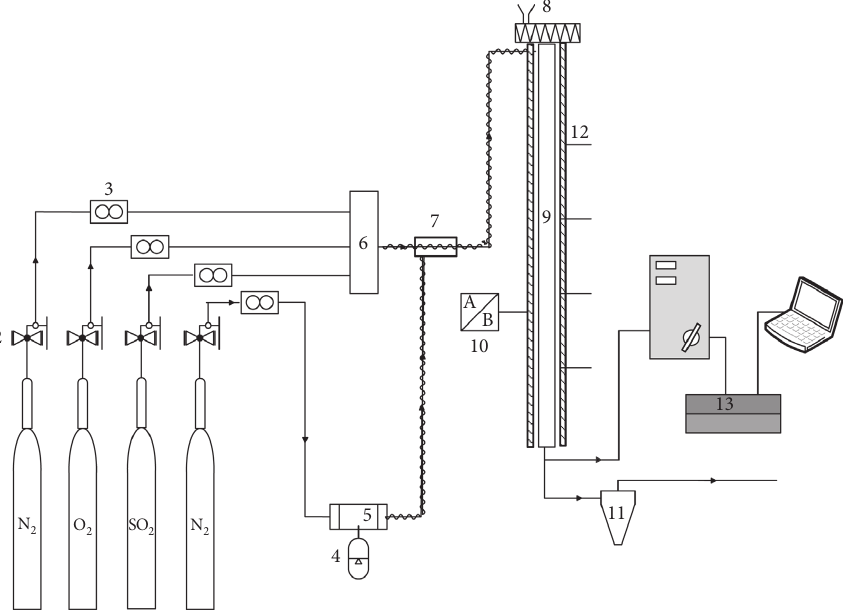
Figure 1: Diagram of the drop tube furnace. 1. Gas cylinder. 2. Pressure reducing valve. 3. Flowmeter. 4. Peristaltic pump. 5. Evaporator. 6 and 7. Mixer. 8. AC feeder. 9. Reactor. 10. Electric heater. 11. Cyclone. 12. Sampling hole. 13. Gas